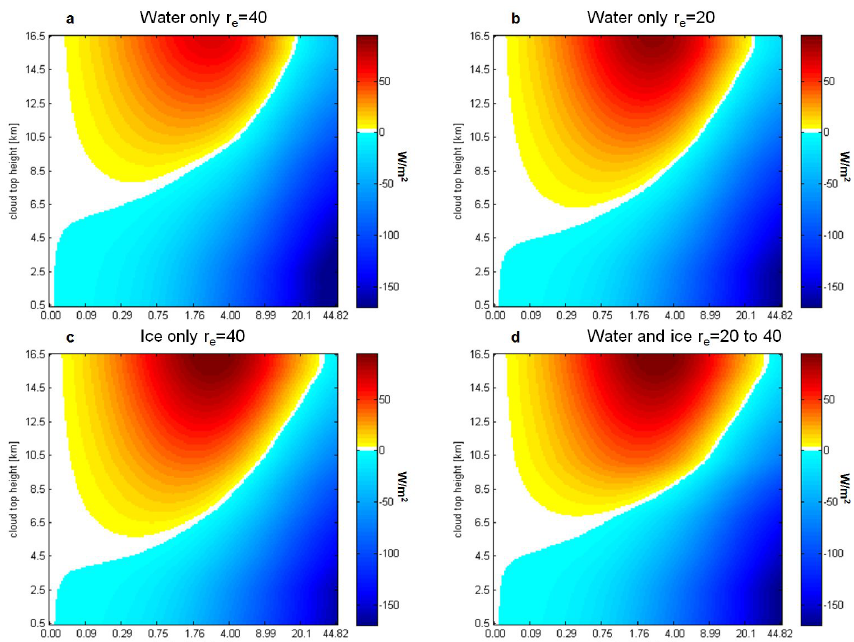
Fig. 5. Sensitivity of the cloud τ - Z space to the cloud thermodynamic phase and the effective radius of the cloud particles ( r e ) . (a) Water clouds with r e =40µm. (b) Water clouds with r e =20µm. (c) Only ice particles with r e =40µm. (d) Corresponds to Fig. 3 with mixed phase and a range of particle sizes from r e =20µm at low altitudes to 40µm at upper altitudes. The white color represents the zero net forcing and marks the transition from negative forcing (cooling, cold colors) to positive (warming, hot colors). Following the location of the transition zone reveals that the tendency is for the warming effect to extend to lower altitudes for ice phase and smaller